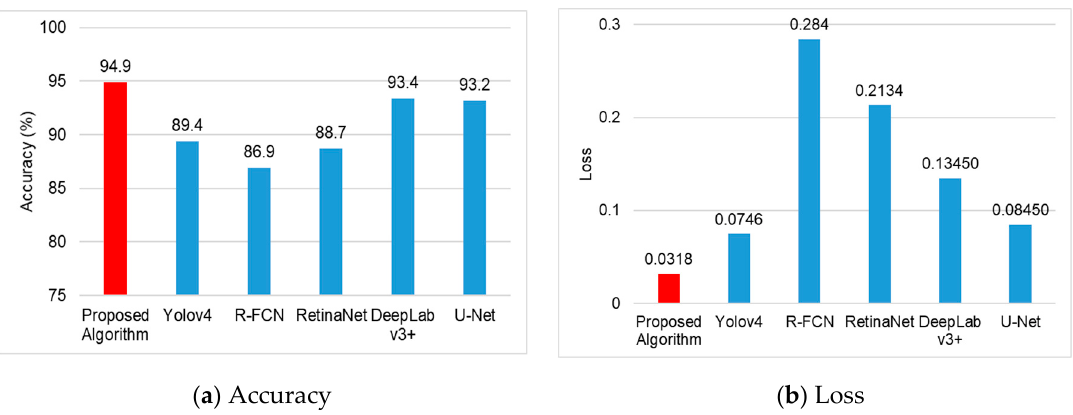
Figure 12. The accuracy measurement result of the lesion object detection algorithm.